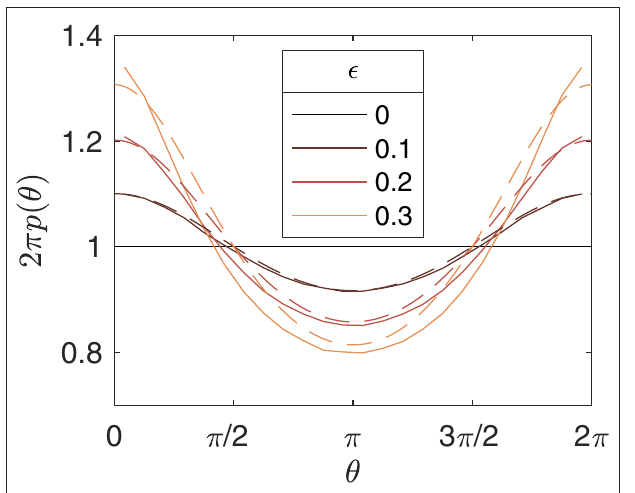
FIGURE 4 | Normalized probability density function 2 π p ( θ ) of particles in the water column as a function of wave phase. The ratio A / L m from 0 (no waves) to 0.3. The solid line shows results calculated from numerical simulations and the dashed line shows Equation (10).